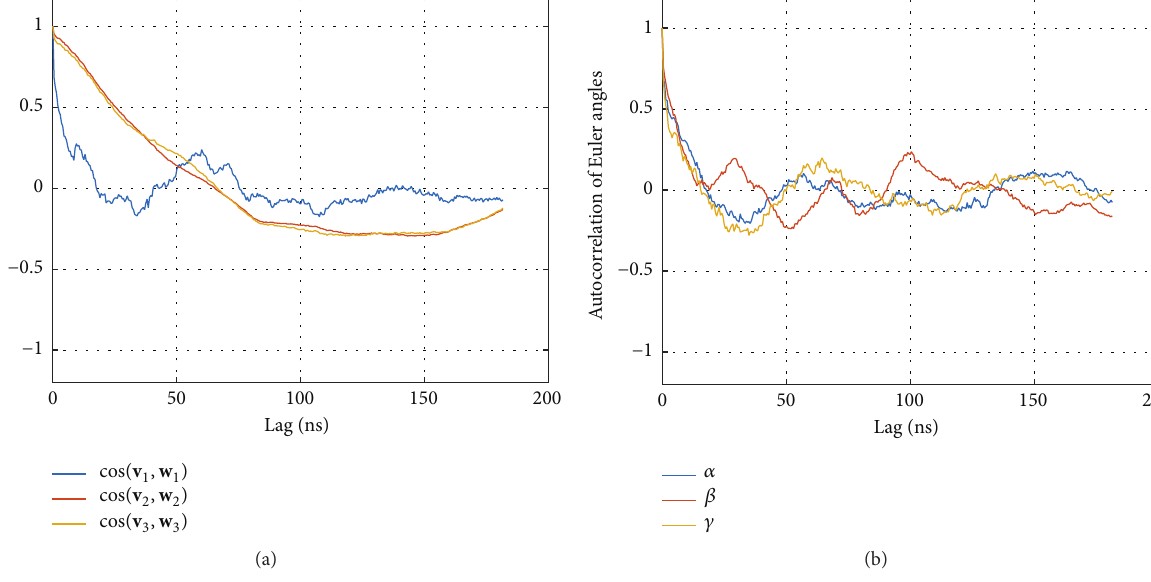
In fact this kind of movement is also evident when visually inspecting the trajectories in VMD